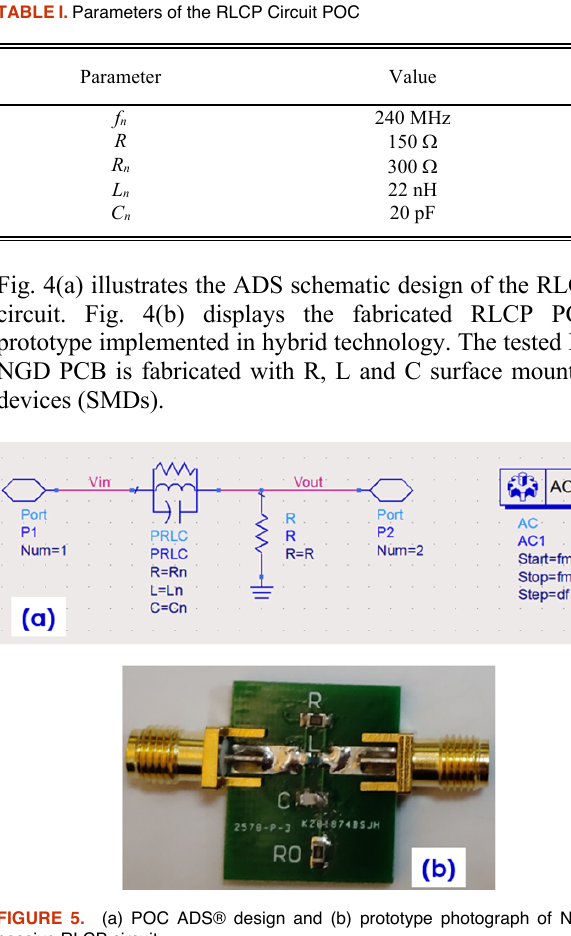
TABLE I. Parameters of the RLCP Circuit POC